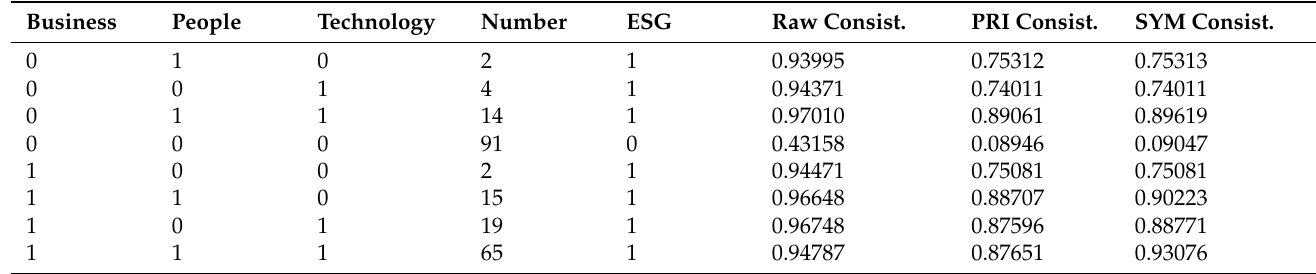
Table 2. Fuzz set truth